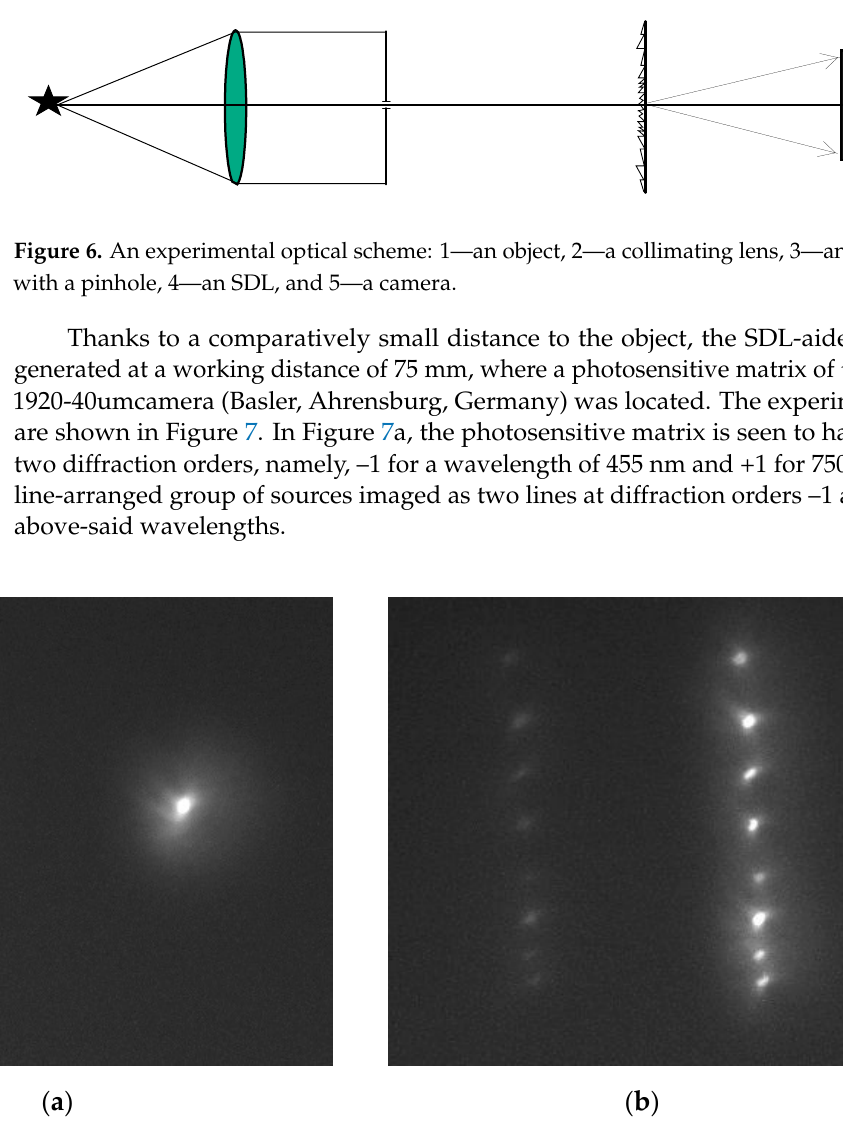
line-arranged group of point sources.